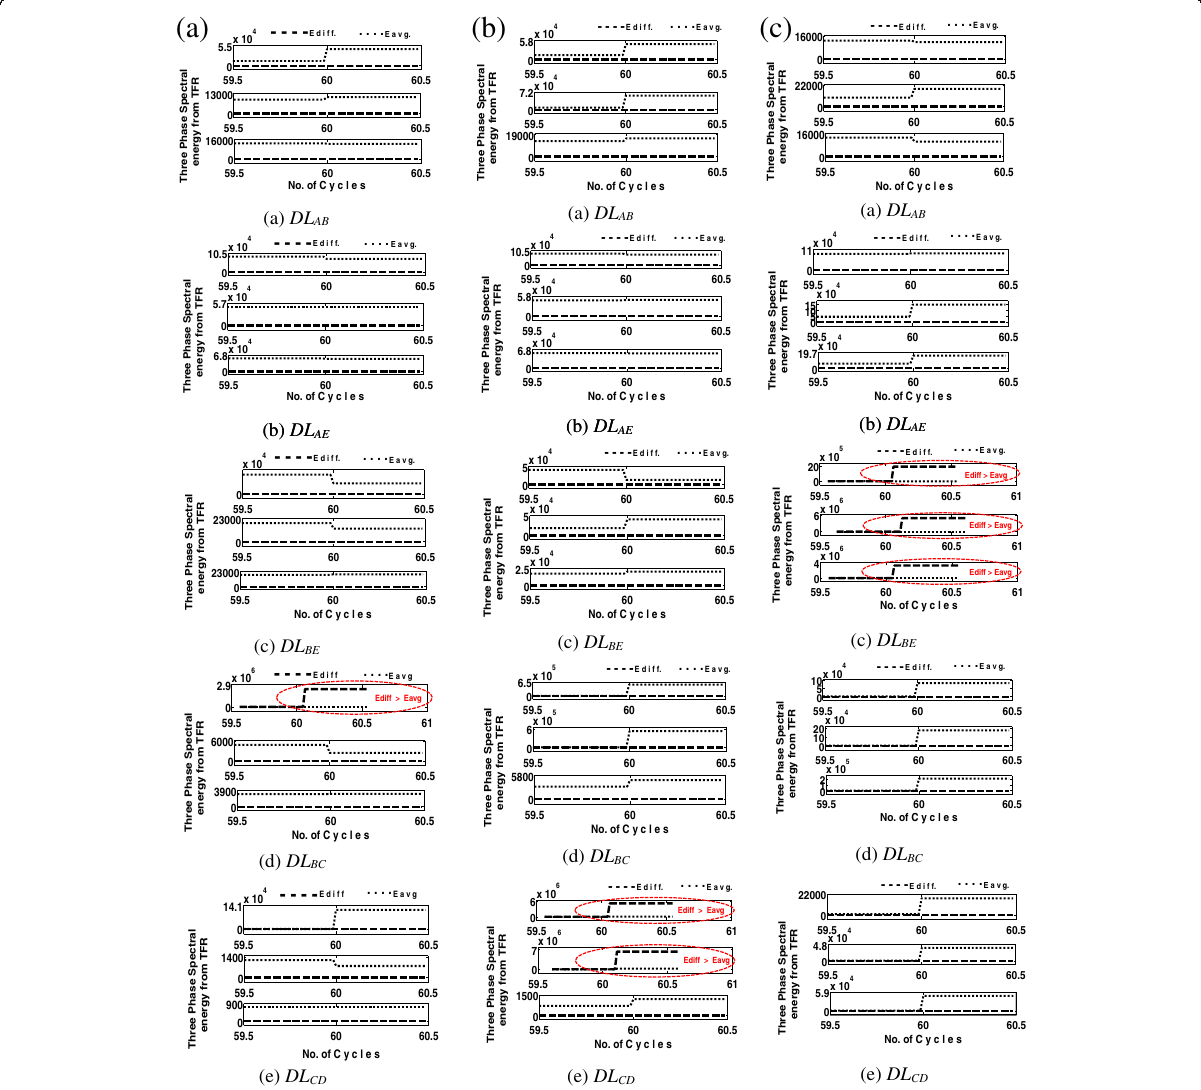
Fig. 4 a The three phase spectral energy from TFR for differential ( − – ) and average ( … .) currents, for the grid connected microgrid subjected to a single phase to ground fault (a-g) on distribution line DLBC (with FDR 0.3, and Rf = 0.1 Ω ), where, responses are for distribution lines ( a ) DLAB, ( b ) DLAE, ( c ) DLBE, ( d ) DLBC and ( e ) DLCD, respectively. b The three phase spectral energy from TFR for differential ( − – ) and average ( … .) currents, for the grid connected microgrid subjected to a double phase to ground fault (ab-g) on distribution line DLCD (with FDR 0.5, and Rf = 1 Ω ), where, responses are for distribution lines ( a ) DLAB, ( b ) DLAE, ( c ) DLBE, ( d ) DLBC and ( e ) DLCD, respectively. c The three phase spectral energy from TFR for differential ( − – ) and average ( … .) currents, for the grid connected microgrid subjected to a triple phase to ground fault (abc-g) on distribution line DLBE (with FDR 0.7, and Rf = 10 Ω ), where, responses are for distribution lines ( a ) DLAB, ( b ) DLAE, ( c ) DLBE, ( d ) DLBC and ( e ) DLCD,